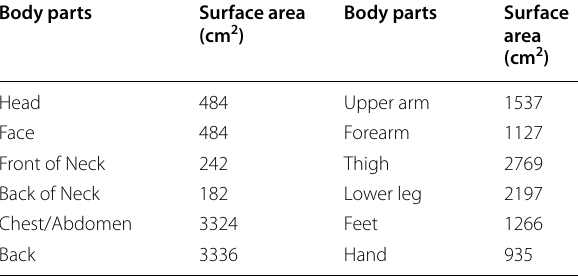
Table 1 Body surface area for the Korean adult